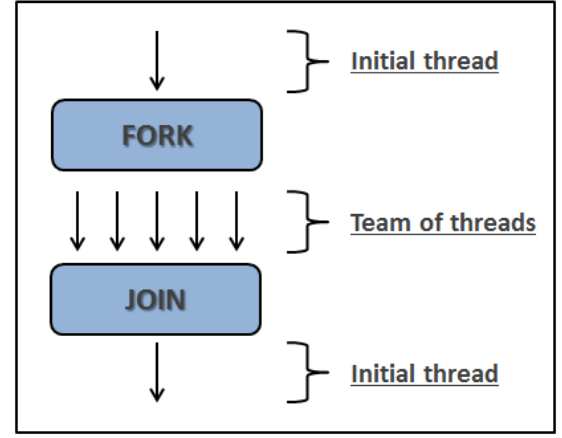
Figure 2. The OpenMP fork-join programming